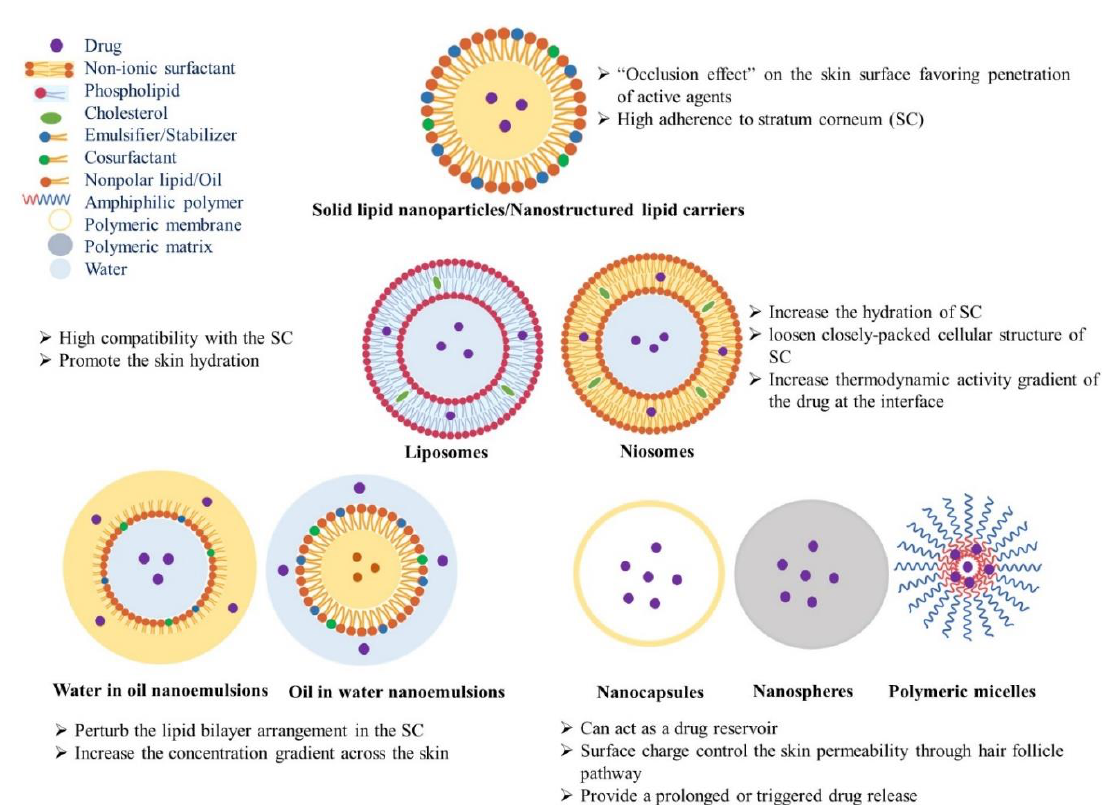
Figure 1. Vesicular, lipid and polymer-based nanoparticles (NPs) currently used in nanomedicine and their underlying mechanisms for enhanced transdermal delivery (TDD).